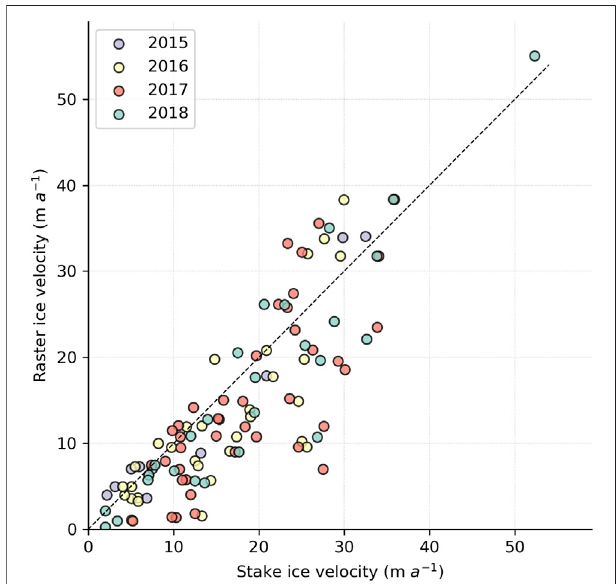
FIGURE 6 | Surface ice velocity from 99 stake measurements on Conrad, Kokanee, Nordic and Zillmer glaciers vs. feature-tracking-derived velocity fi